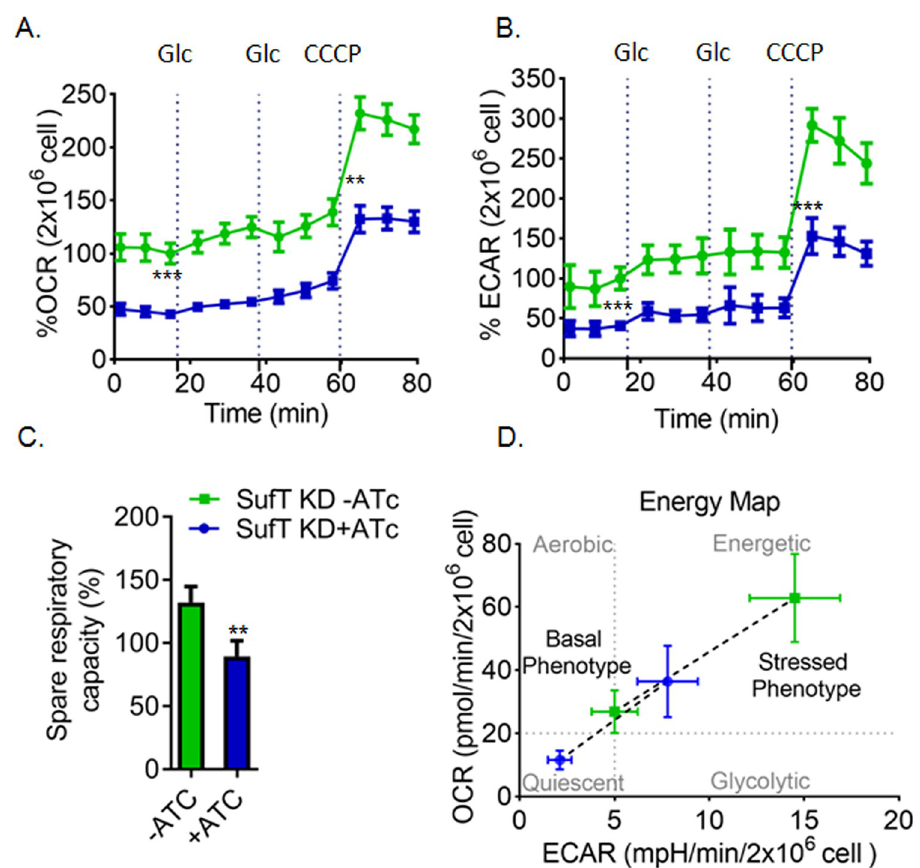
Fig 6. Depletion of SufT results in reduced OCR and ECAR. (A) A change in % oxygen consumption rate (% OCR) and (B) % extra cellular acidification rate (% ECAR) of SufT-KD strain precultured for 72 h in the presence (+ATc) or absence (–ATc) of ATc and was measured after injection of 5 mM glucose (Glc) and 5 μ M CCCP indicated by dotted lines. The uncoupler CCCP was used to determine the spare respiratory capacity (SRC). (C) Decrease in 20% SRC of SufT-KD+ATc with respect to SufT-KD-ATc. Percentage SRC was calculated by subtracting basal OCR (point before adding first Glc) to CCCP induced OCR. (D) Agilent Seahorse XF based Cell Energy Phenotype Profile of SufT-KD. The relative utilization of the two energy pathways (oxidative phosphorylation and glycolysis) is determined under both baseline (Baseline Phenotype) and stressed (Stressed Phenotype) condition after CCCP addition. All point of OCR and ECAR are normalized to CFU (2x10 6 cells/well) and calculated in percent with respect to third basal point. Seahorse XF analyzer experiment was performed in triplicate with two independent replicates. Student’s t test (two tailed) was performed here with p values, � p � 0.05, �� p � 0.01 and ��� p �